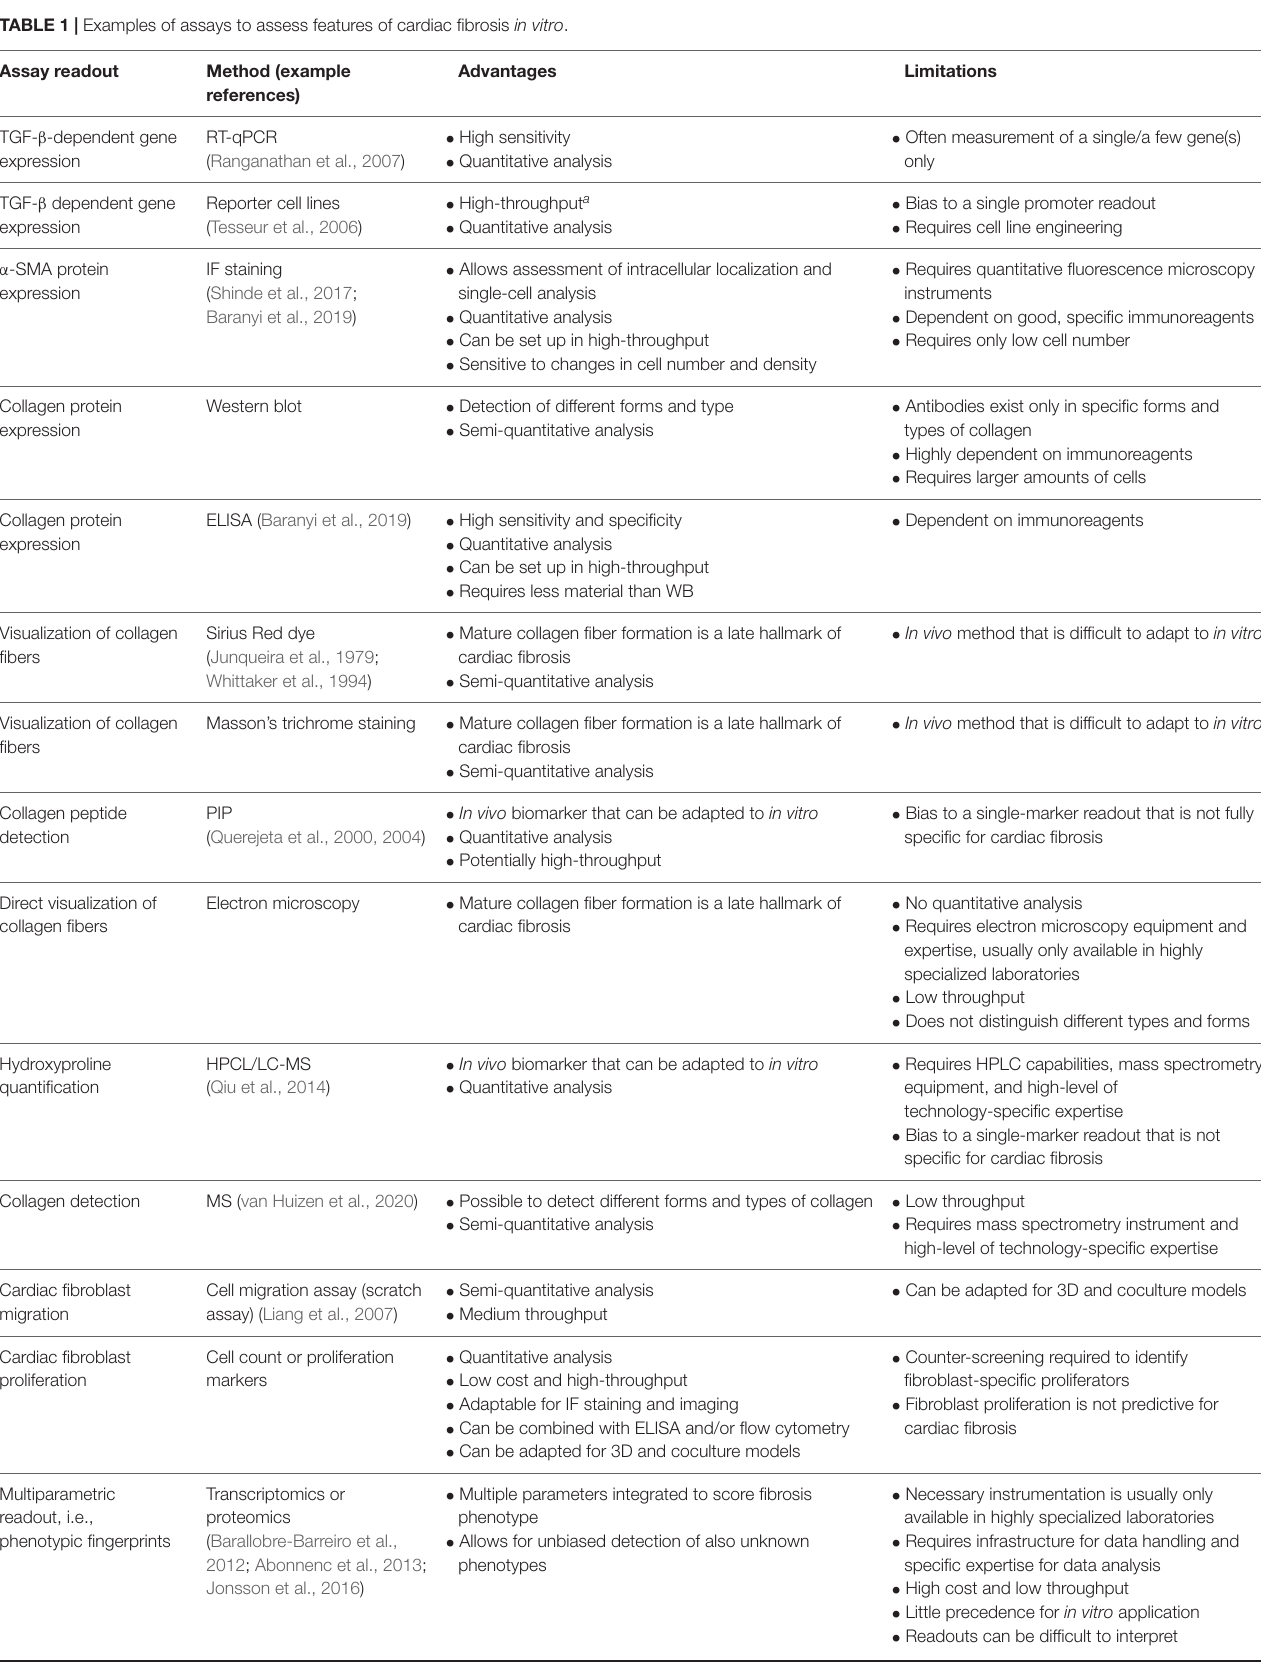
TABLE 1 | Examples of assays to assess features of cardiac fibrosis in vitro . Assay